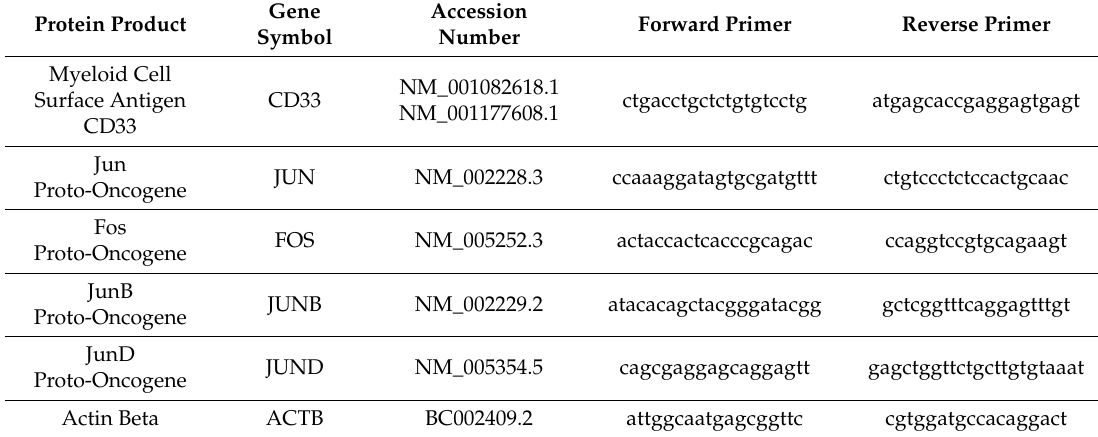
Table 1. List of the primers used in the